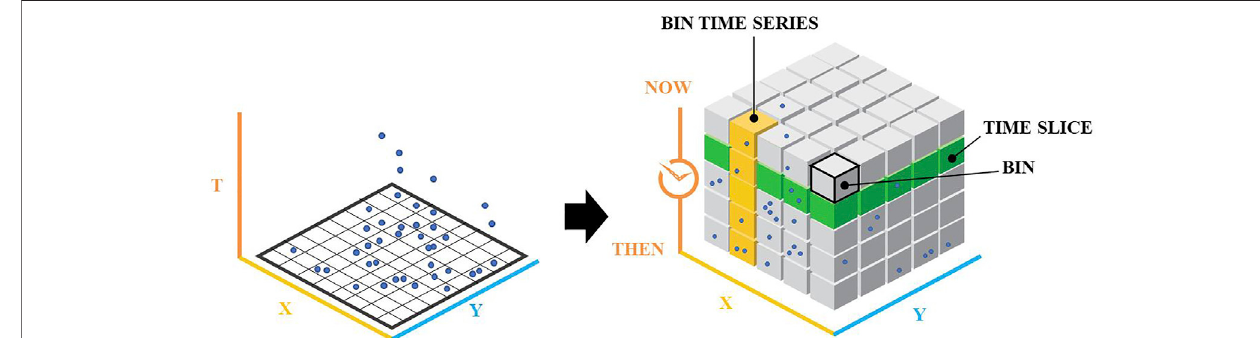
FIGURE 2 | Space Time cube.